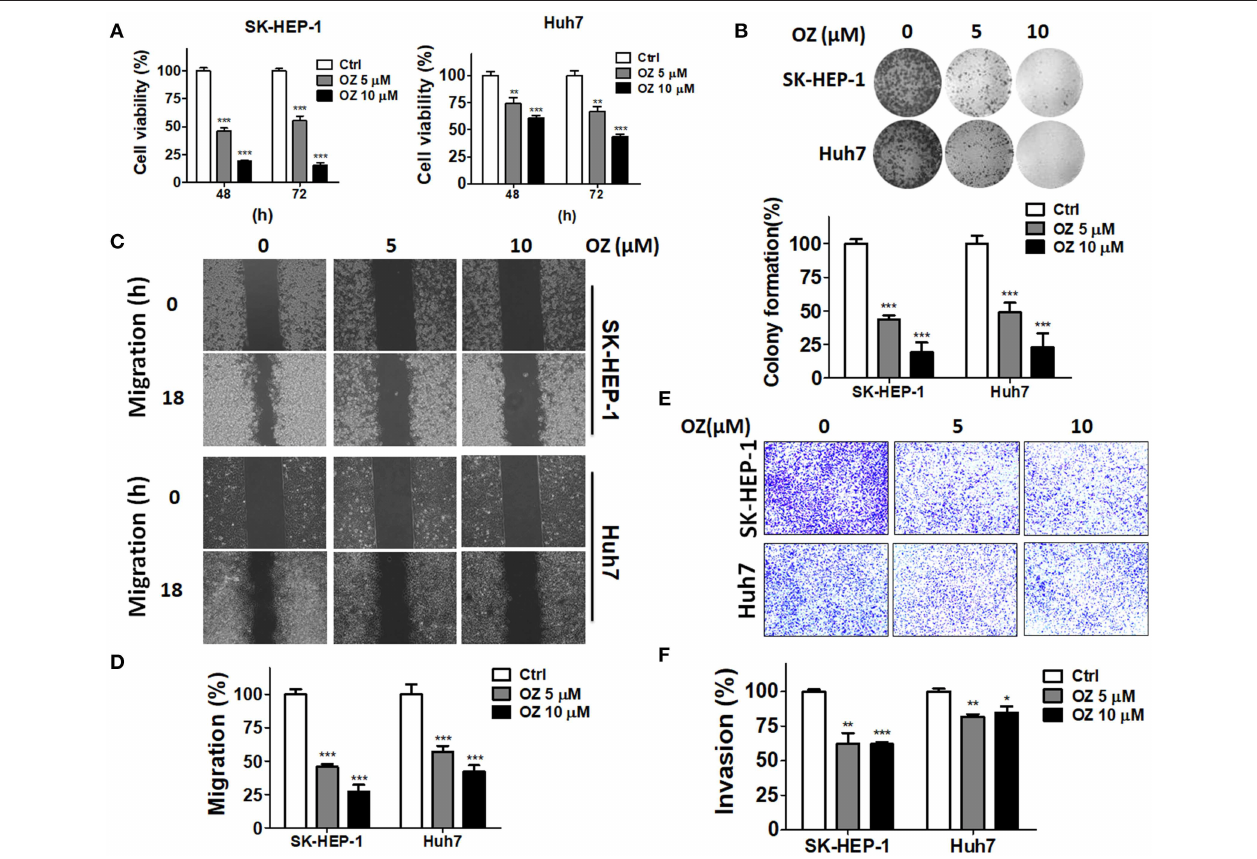
FIGURE 3 | Effects of a MAP3K7 inhibitor on the cytotoxicity, migration, and invasion of HCC cells. (A) SK-HEP-1 and Huh7 cells were treated with the MAP3K7 inhibitor (5Z)-7-oxozeaenol for 48 or 72h to measure cell proliferation with CellTiter Glo and (B) colony formation. (C) The cells were incubated overnight in a culture insert, and the insert was removed to assess cell migration in the presence or absence of (5Z)-7-oxozeaenol. (E) The effects of (5Z)-7-oxozeaenol on the invasion of HCC cells were determined by Matrigel-coated Transwell filters. The quantified results for migration (D) and invasion (F) are expressed as the mean ± SEM from three independent experiments. * p < 0.05; ** p < 0.01; *** p <